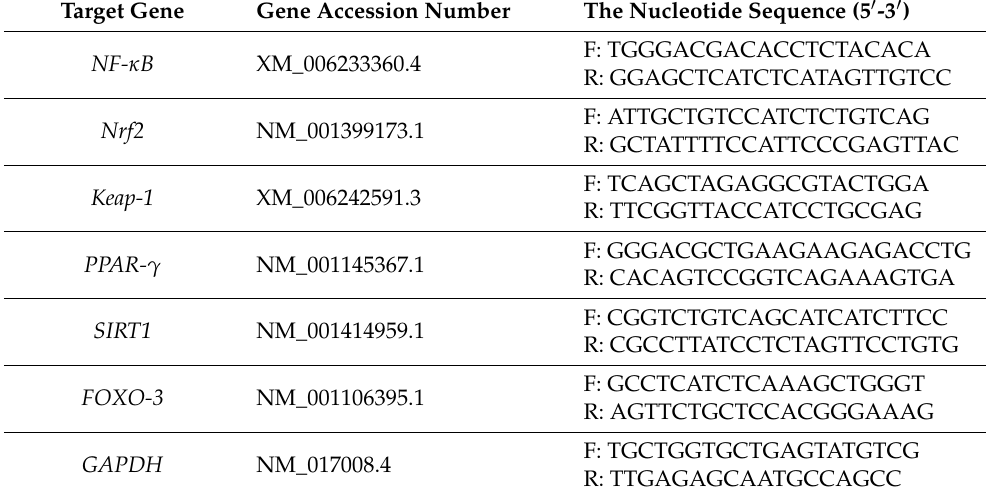
Table 2. Primer list for qRT-PCR. Target